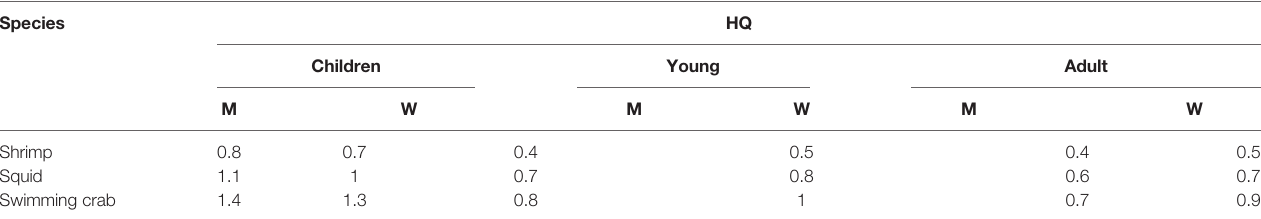
TABLE 3 | Results of the Hazard Quotient evaluation in three age groups of the consumer population of squid, shrimp, and swimming crabs sampled from Guanabara Bay, Rio de Janeiro, southeastern Brazil. Species